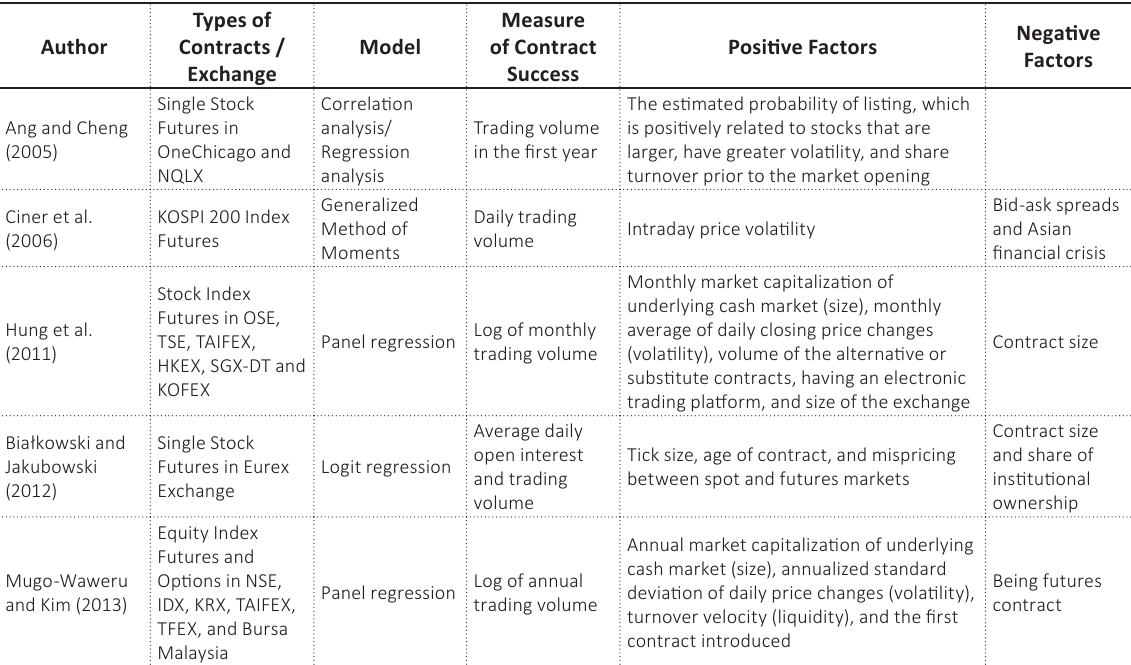
Table 1. Summary of previous literature on determinants of equity derivative product